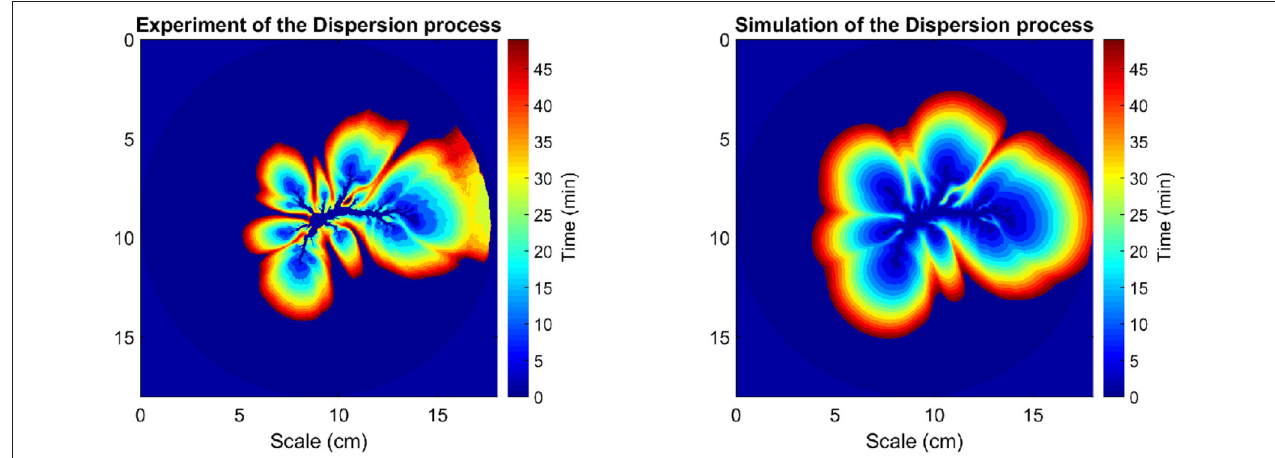
FIGURE 5 | Experimental image (E) and simulation image (S) are resized gray-scaled images from original RGB images. difference between experiment and simulation. γ SOL is the structure overlap ratio which compares the black-white images of E and S. γ IOL is the intensity overlap ratio comparing E and S which are gray-scaled